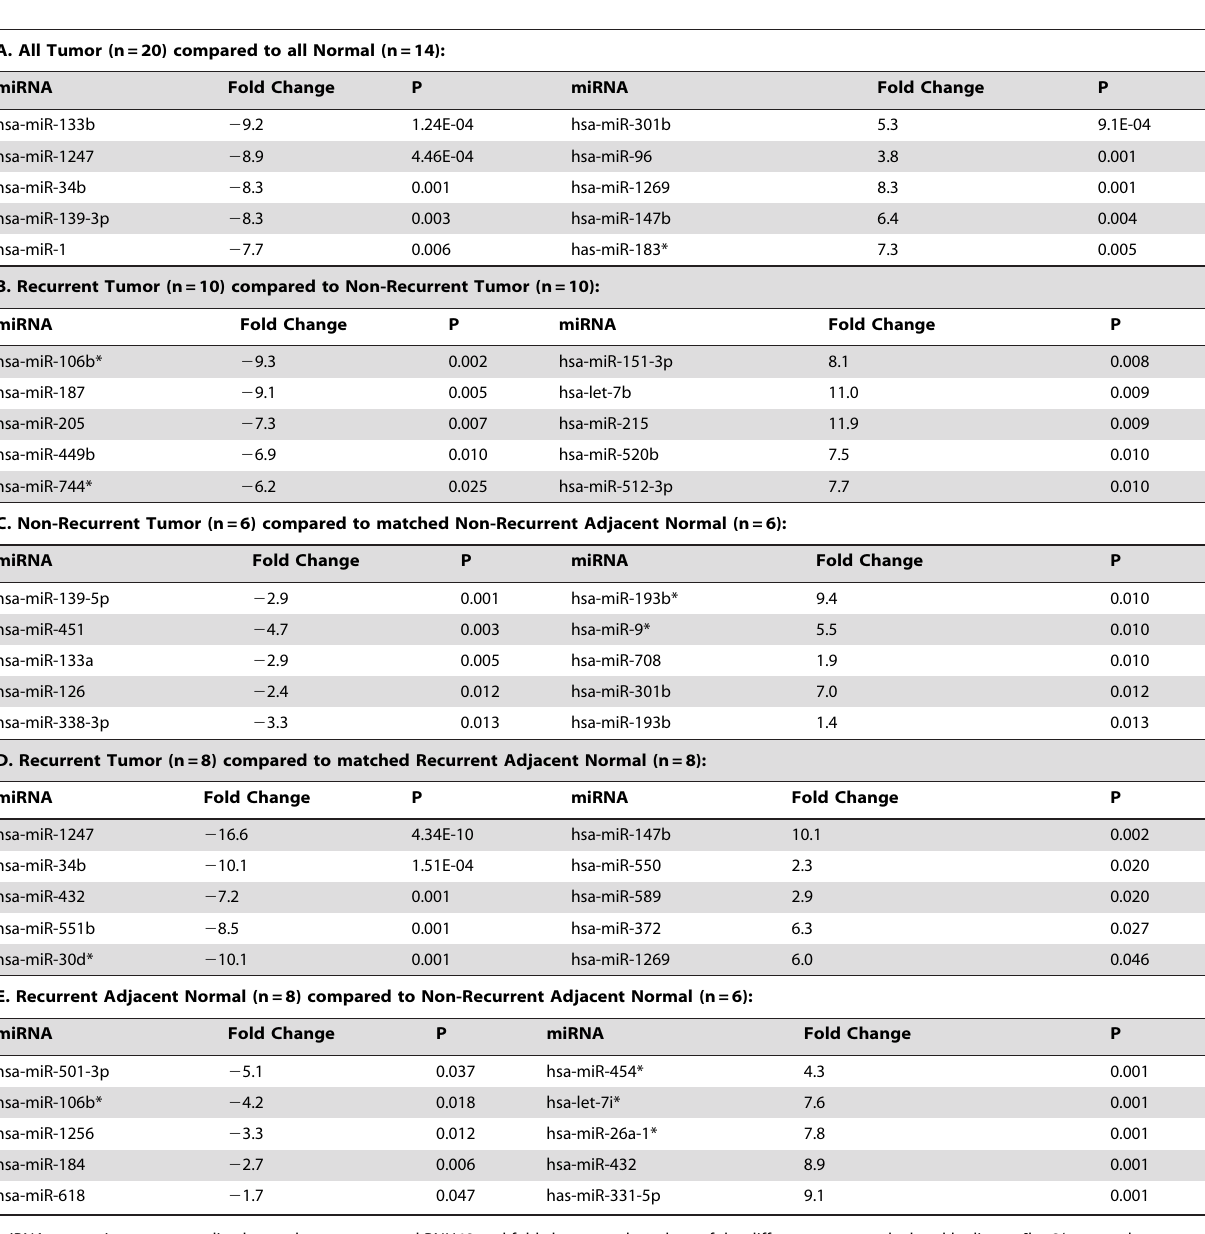
Table 2. Comparisons of miRNA expression between lung adenocarcinomas that did or did not recur and adjacent normal lung